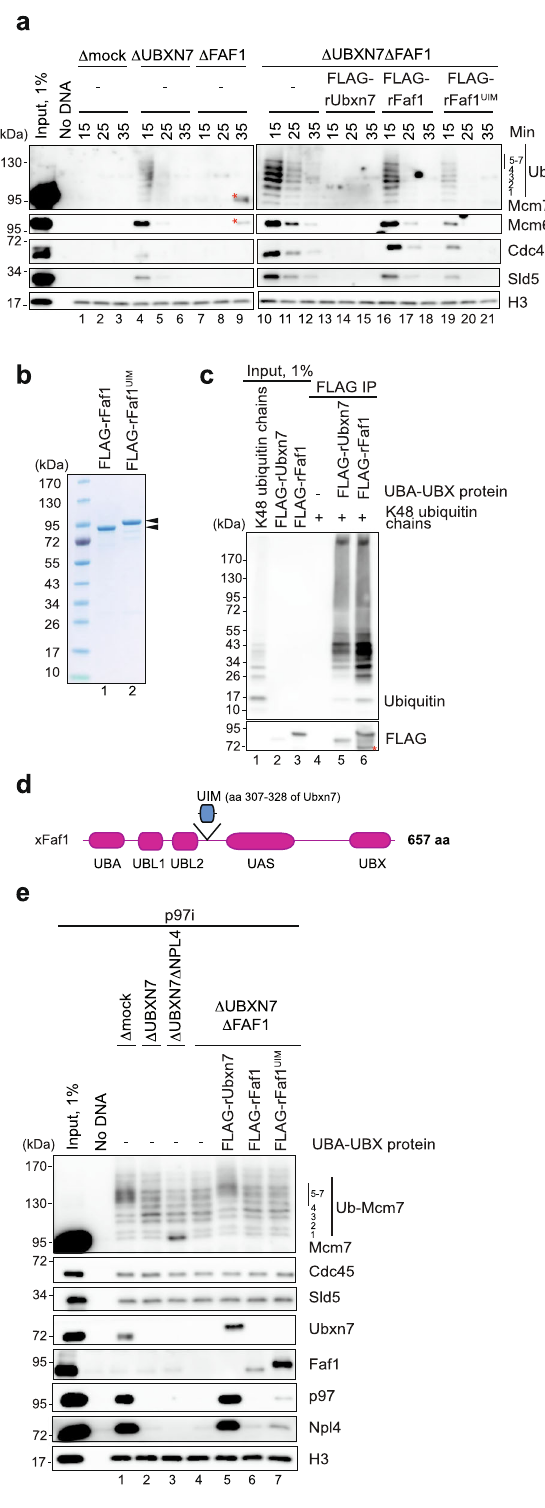
Fig. 4 | Faf1 ’ s back-up function in CMG unloading can be enhanced by Ubxn7 ’ s UIM motif. a Analysis of chromatin-bound proteins in mock-, Ubxn7-, Faf1-, or Ubxn7/Faf1-depleted extracts. At indicated time points after replication initiation, plasmid DNA was recovered with LacR-coated beads and immunoblotted for the indicatedproteins.Lanes1 – 9and10 – 21arepartsofthesameexperimentthatwere analyzed on separate Western blots processed and imaged in parallel under iden- tical conditions. Red asterisks indicate non-speci fi c band that is likely contamina- tion with non-reduced heavy chains of rabbit IgG. See Supplementary Fig. 6a for immunodepletion ef fi ciency and 6b for independent replicate. Ub-Mcm7, ubiqui- tylatedMcm7. b Animageofpolyacrylamidegelofrecombinantwild-typeFaf1and Faf1 UIM chimera. Black arrowheads indicate Faf1-speci fi c bands. c Analysis of co- immunoprecipitates of FLAG-rUbxn7 or FLAG-rFaf1 with K48-linked ubiquitin chains.RecombinantUbxn7and Faf1weredetectedbyusinganti-FLAGantibodies. Red asterisk indicates C-terminal truncation of recombinant Faf1. IP immunopre- cipitation. d Domain composition of Xenopus Faf1 and the Faf1 UIM chimera. In Faf1 UIM , the UIM motif of Ubxn7 was inserted between amino acidresidues 293and 294 of Faf1. UBX ubiquitin regulatory X domain, UIM Ubiquitin Interacting Motif, UBAubiquitin-associateddomain, UBL1,2ubiquitin like domain1,2,UASubiquitin associating domain. e Analysis of chromatin-bound proteins in mock-, Ubxn7-, Ubxn7-Npl4-,orUbxn7/Faf1-depletedextractsinthepresenceofp97iandwild-type Ubxn7, wild-type Faf1, or the Faf1 UIM chimera. See also Supplementary Fig. 7a for immunodepletion ef fi ciency. Source data are provided as a Source Data fi